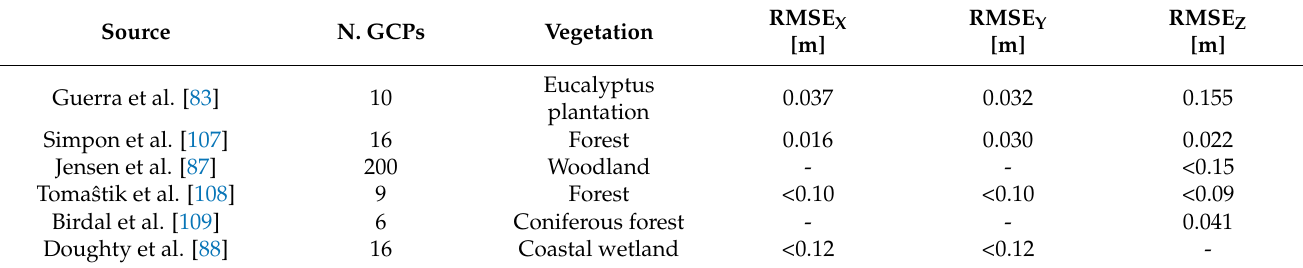
Table 5. Literature source, general information, and statistics of various studies using DAP-UAV